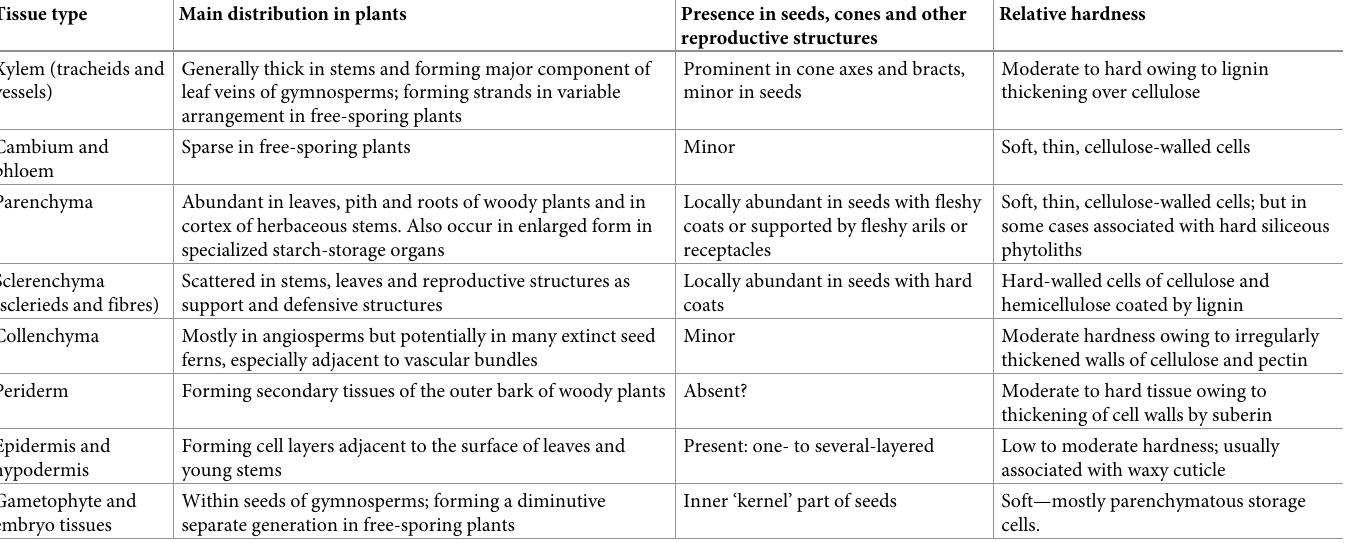
Table 5. Interpreted hardness of specific plant tissues as components of vertebrate